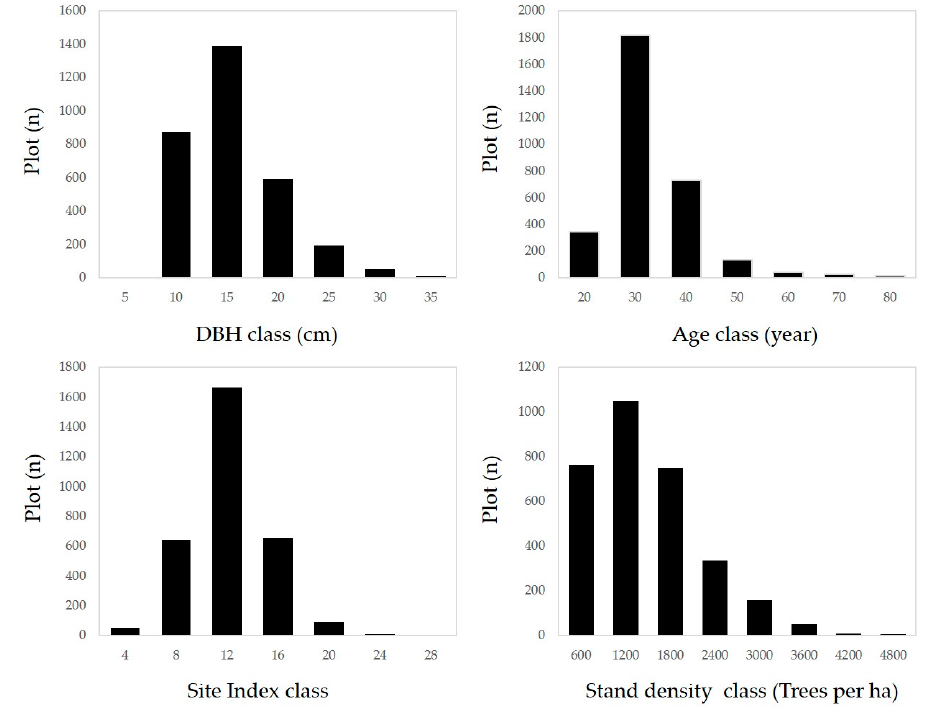
Figure 2. Extensive diversity of each factor (DBH, age, site index and stand density) by plot ( Pinus densiflora Siebold & Zucc.), based on the 5th National Forest Inventory data.